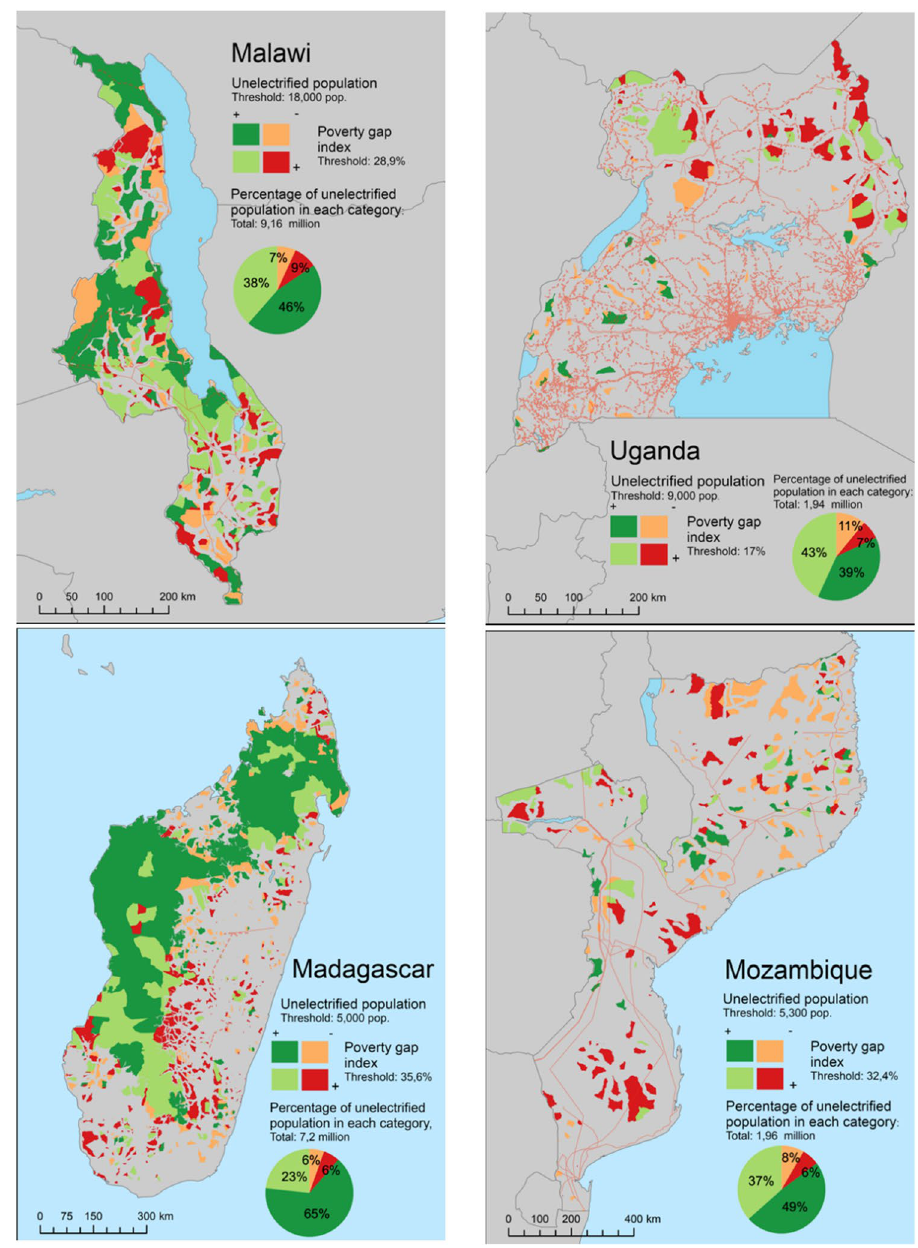
Figure 6. “Low-hanging fruit” PV areas in ( a ) Malawi, ( b ) Uganda, ( c ) Madagascar and ( d ) Mozambique. The analysis is restricted to no-regret PV option areas. Dark green-coloured areas correspond to “low-hanging fruit” areas, that is, communities with larger-than-average unelectrified populations (potential new costumers) that are wealthier than the average in the country. Dark red-coloured areas corresponds to those areas with smaller unserved populations that are poorer than the average. The values of specific thresholds are detailed in the maps. The maps were generated using the following data, collected and processed by the authors: the dataset with the disaggregated unelectrified population (described previously in “2. Mapping unelectrified populations”) , Administrative Level 3 Units, from GADM (https ://gadm.org/) and the Poverty Gap Index—FGT1 at sub- national level from from CIESIN—Columbia University (for Mozambique, Malawi and Madagascar, https :// sedac .ciesi n.colum bia.edu/data/set/povma p-small -area-estim ates-pover ty-inequ ality ) and from World Resources Institute (Uganda, http://datas ets.wri.org/datas et/ugand a-rural -pover ty-data-2005). Software used: ArcGIS 10.6 (https ://deskt op.arcgi s.com/) and GIMP 2.10 (https ://www.gimp.org) for image